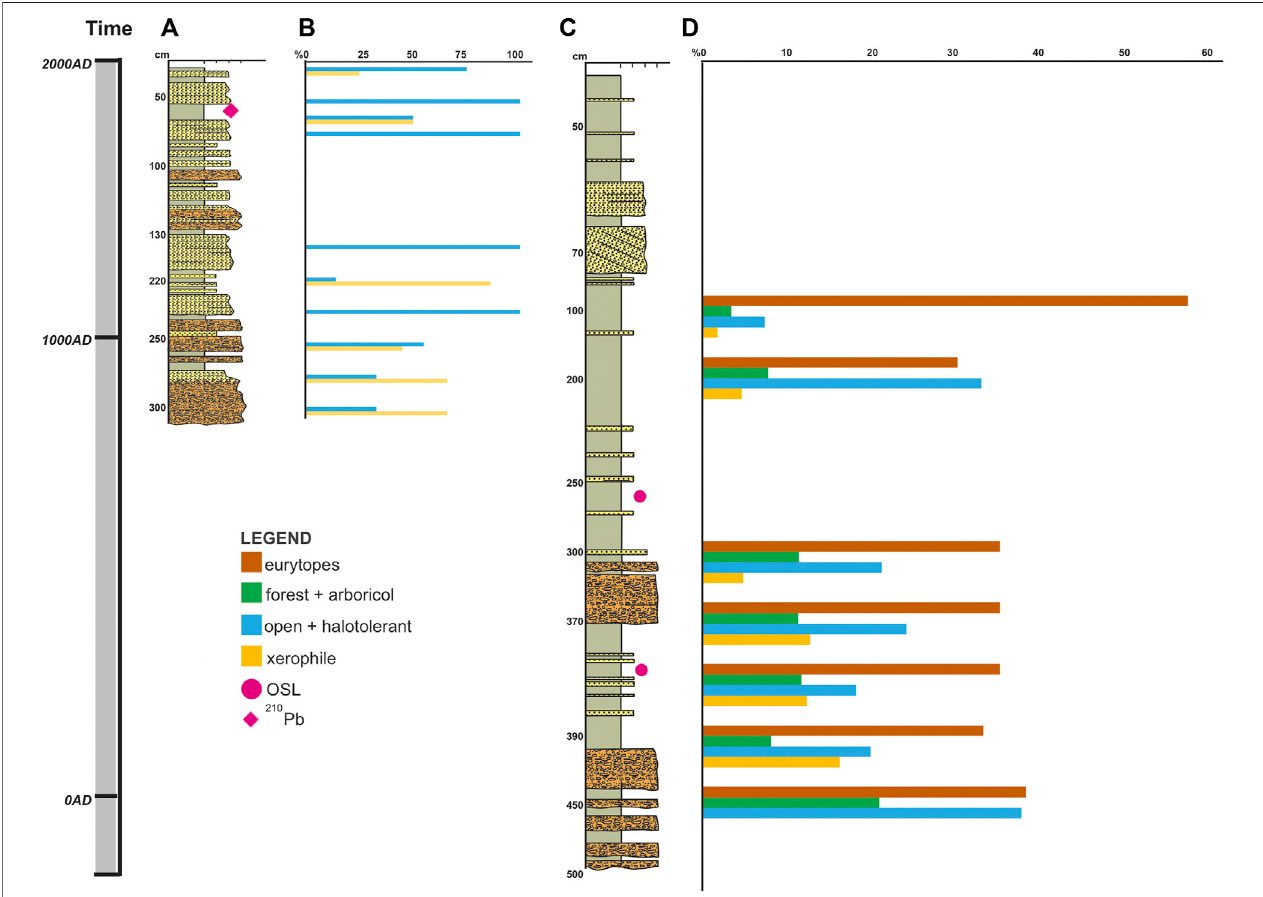
FIGURE7| Ageandthecorrespondingsedimentarypro fi les (A,C) inZ ă tonLakewiththedistributionoforibatidmites(onlyspecieswithmorethan10individuals)in Zaton2 (B) and Zaton3 (D) according to their environmental requirements.